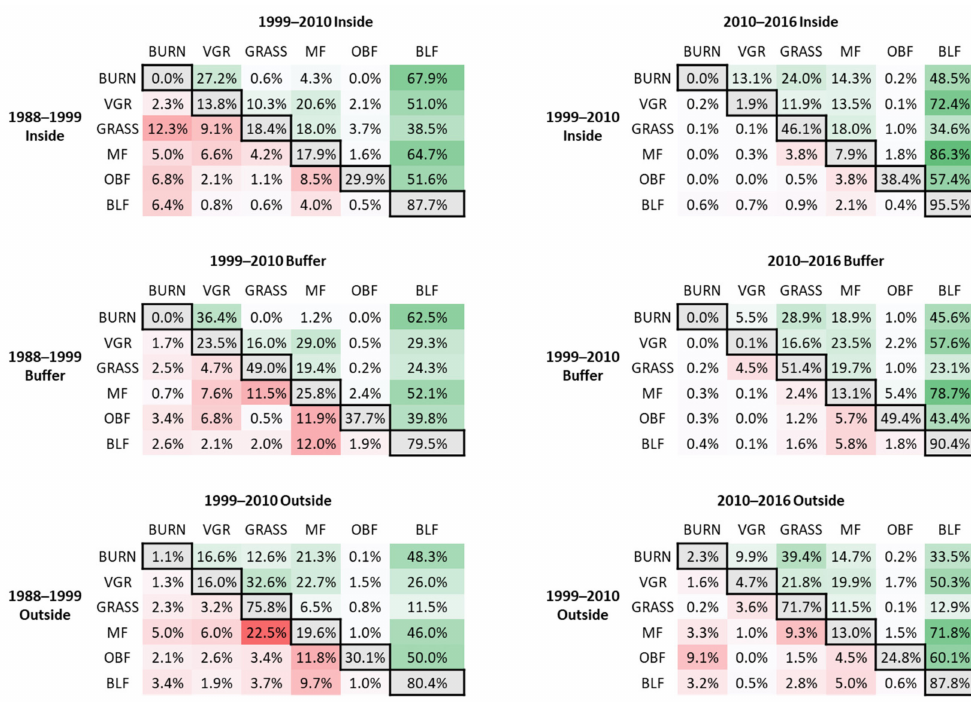
Figure 9. The relative area changes of each class. BURN = burned area, VGR = vegetation recovery, GRASS = grassland, MF = mixed forests, OBF = oak–Daurian birch forests, and BLF = birch and larch